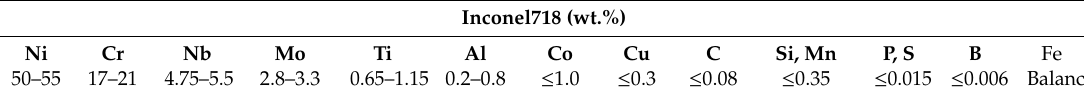
Figure 2. SEM image of Inconel718 powders ( a ); granulometry distribution ( b ). Table 2. Chemical composition of Ti64Al4V.